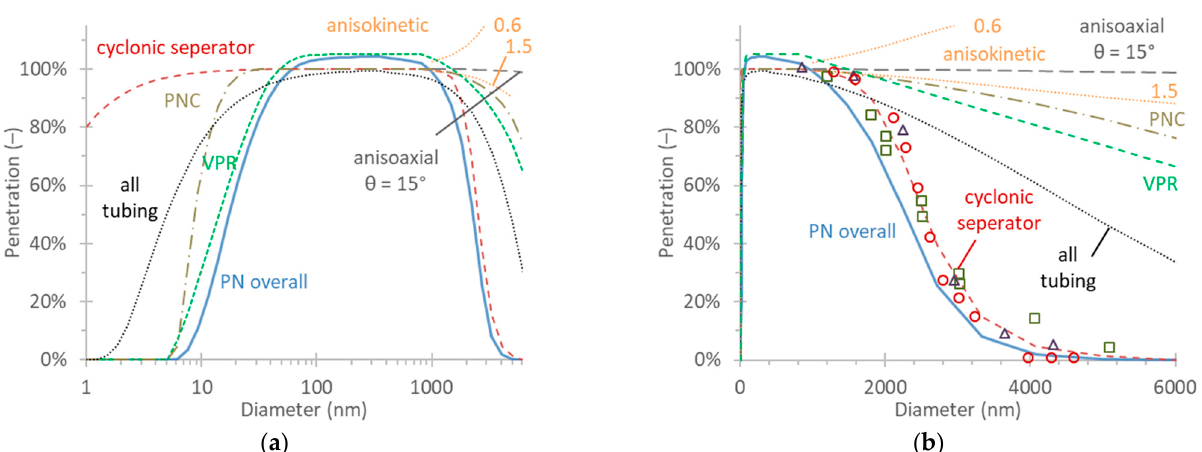
Figure 4. Penetration of the PN setup assuming maximum flexibilities from the technical requirements and using a 2.5 μ m cyclonic separator (“min penetration” setup): ( a ) logarithmic x-axis; ( b ) linear x-axis. Symbols (squares, triangles, circles) are experimental penetrations from three cyclonic separators.